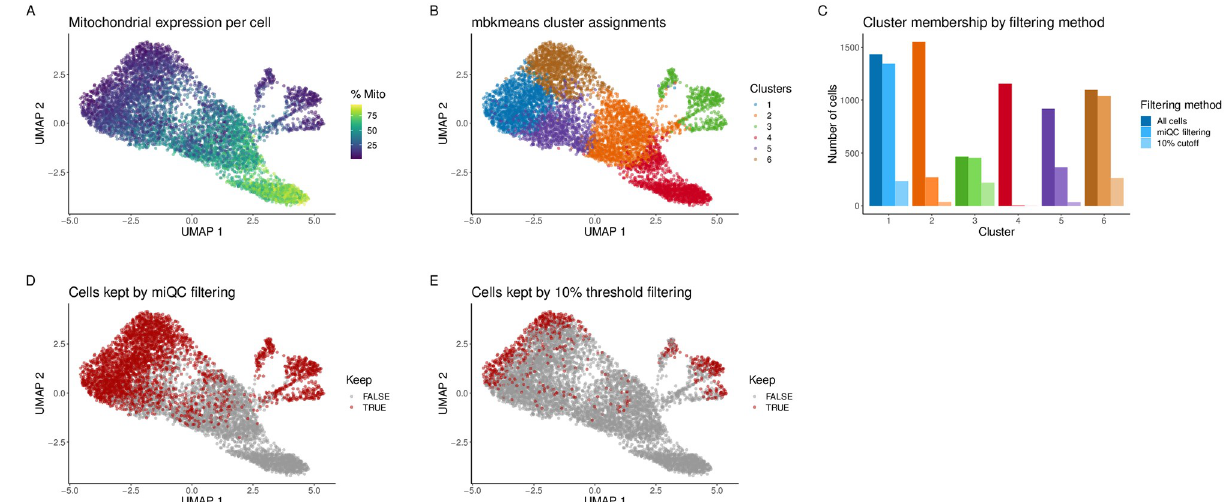
Fig 5. miQC minimizes sub-population bias in unsupervised clustering. Cells ( N = 6691) from one high-grade serous ovarian cancer (HGSOC) tissue sample (Sample ID: 16030X4). (A) UMAP representation of cells, colored by percent of cell counts mapping to mtDNA genes. (B) Predicted cluster labels for k = 6 cell types identified using the mini-batch k -means (mbkmeans) algorithm for unsupervised clustering. (C) Total number of cells preserved within each predicted cluster group using three filtering approaches: no filtering (‘All cells’), miQC filtering, or removing all cells greater than 10% mtDNA content. (D) UMAP representation of cells colored by whether miQC keeps (red) or removes (gray) cells post-QC. (E) Similar as (D), but using a uniform 10% threshold for mtDNA content.